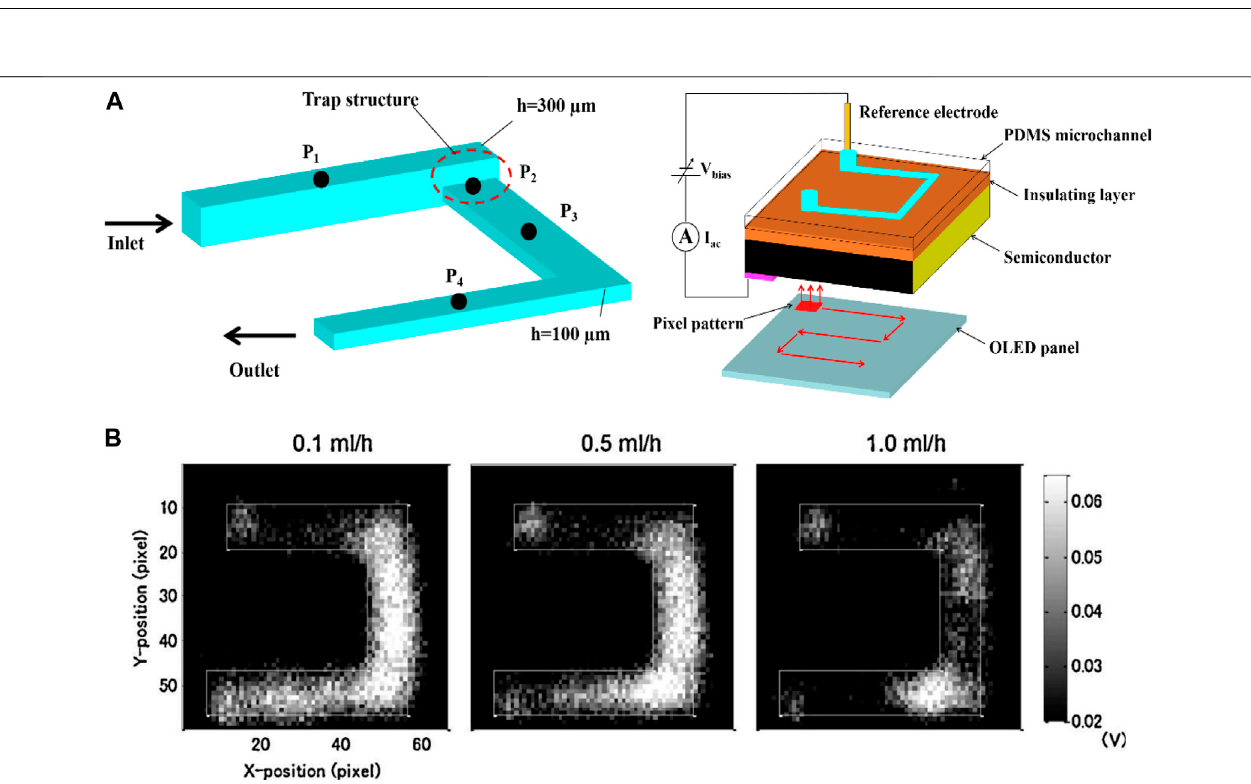
Frontiers in Bioengineering and Biotechnology | www.frontiersin.org February 2022 | Volume 10 | Article 833481